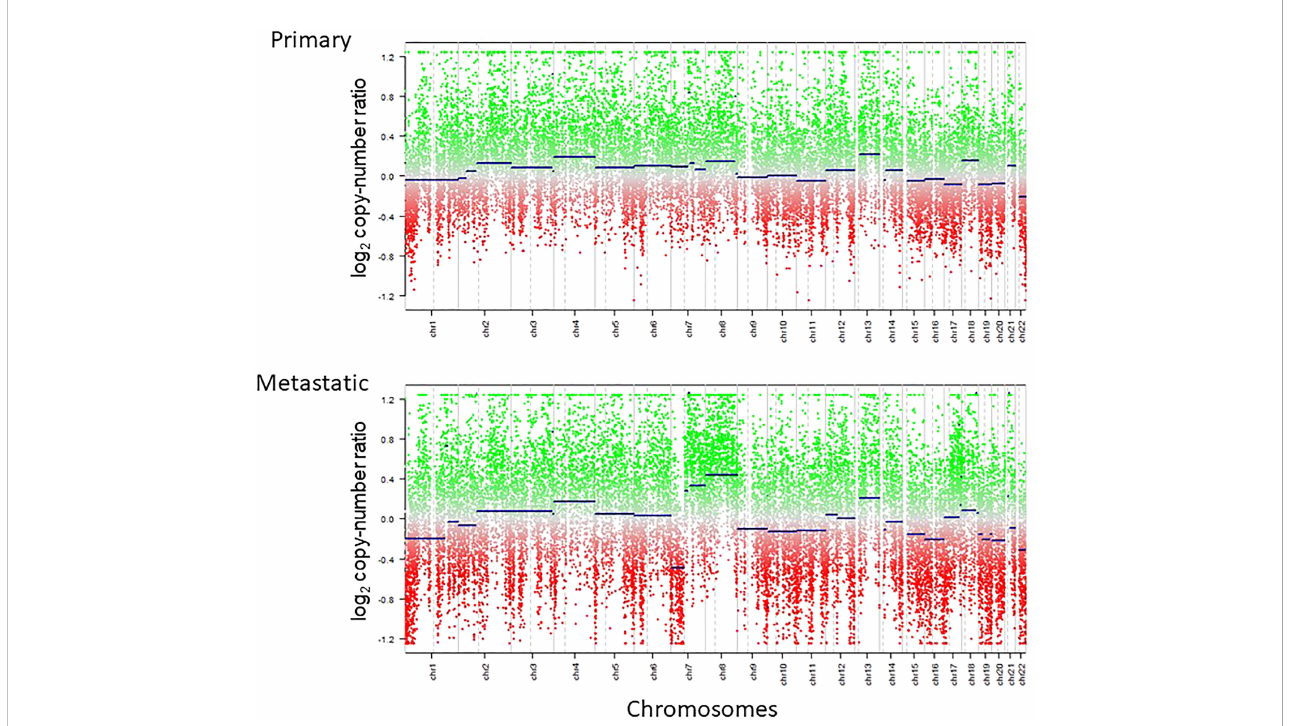
FIGURE 4 Copy number pro fi les of primary and metastatic lesions calculated by methylation array are shown. Copy number baseline imbalance was enhanced for the metastatic lesion compared with the primary